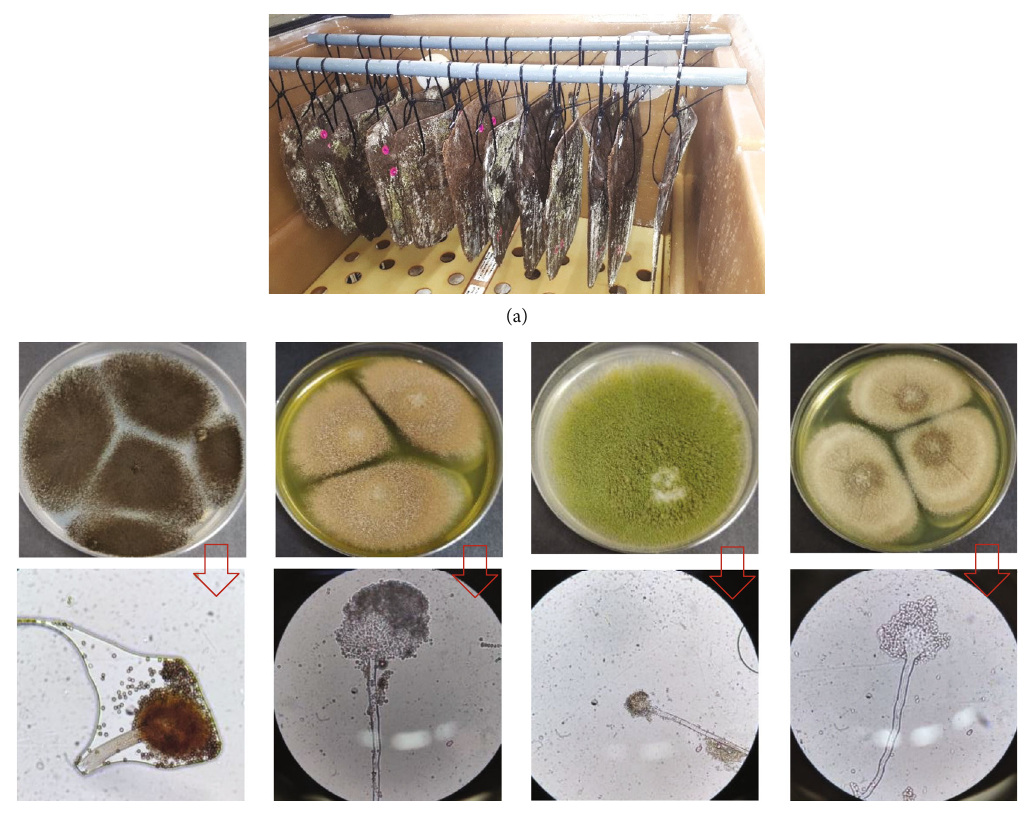
Figure 3: (a) OPEFB/acrylic thermoplastic composites after aging and (b) colony morphology of Aspergillus spp. observed on composite surfaces at macroscopic and microscopic (40x/0.65)